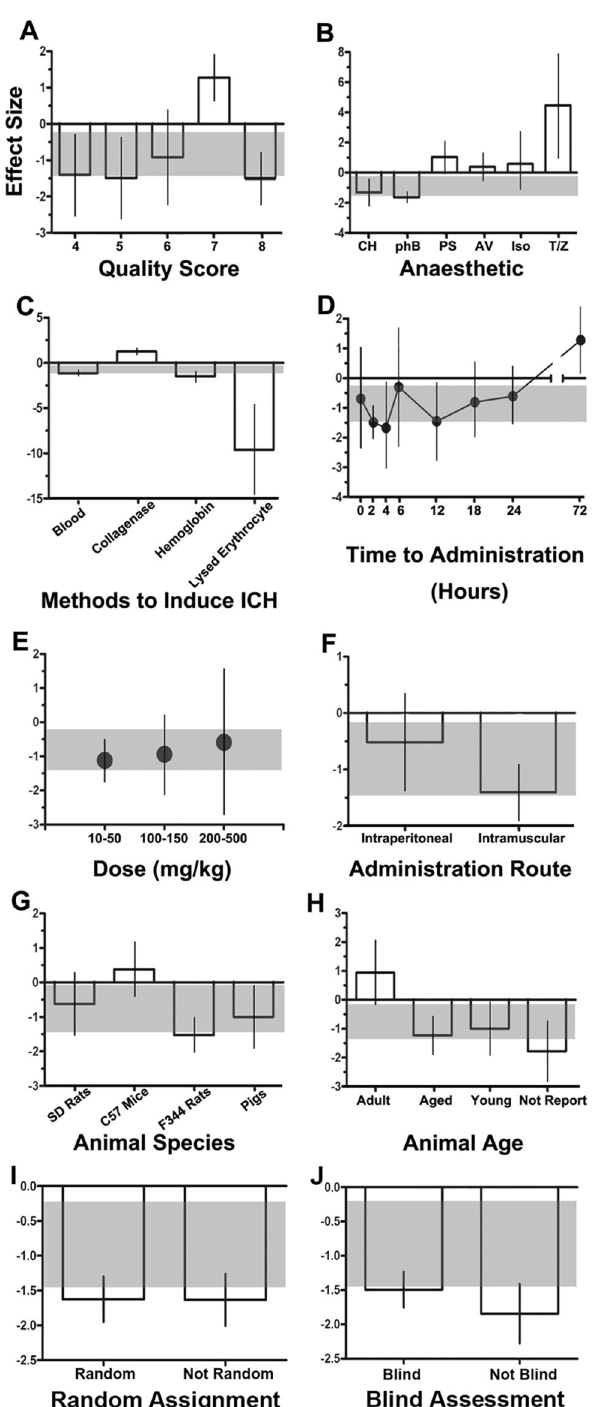
Fig 4. Impact of study design characteristics. This figure shows the effects of the following factors on efficacy, measured as the reduction in brain water content: (A) quality score, (B) anesthetic used during the induction of intracerebral hemorrhage (ICH), (C) route of deferoxamine administration, (D) time of administration, (E) drug dose, (F) methods of ICH induction, (G) animal species, (H) animal age, (I) whether random assignment was used, and (J) whether blind assessment was used. Error bars represent 95% confidence intervals. The horizontal gray bar represents the global estimate of efficacy for brain water content and its 95% confidence